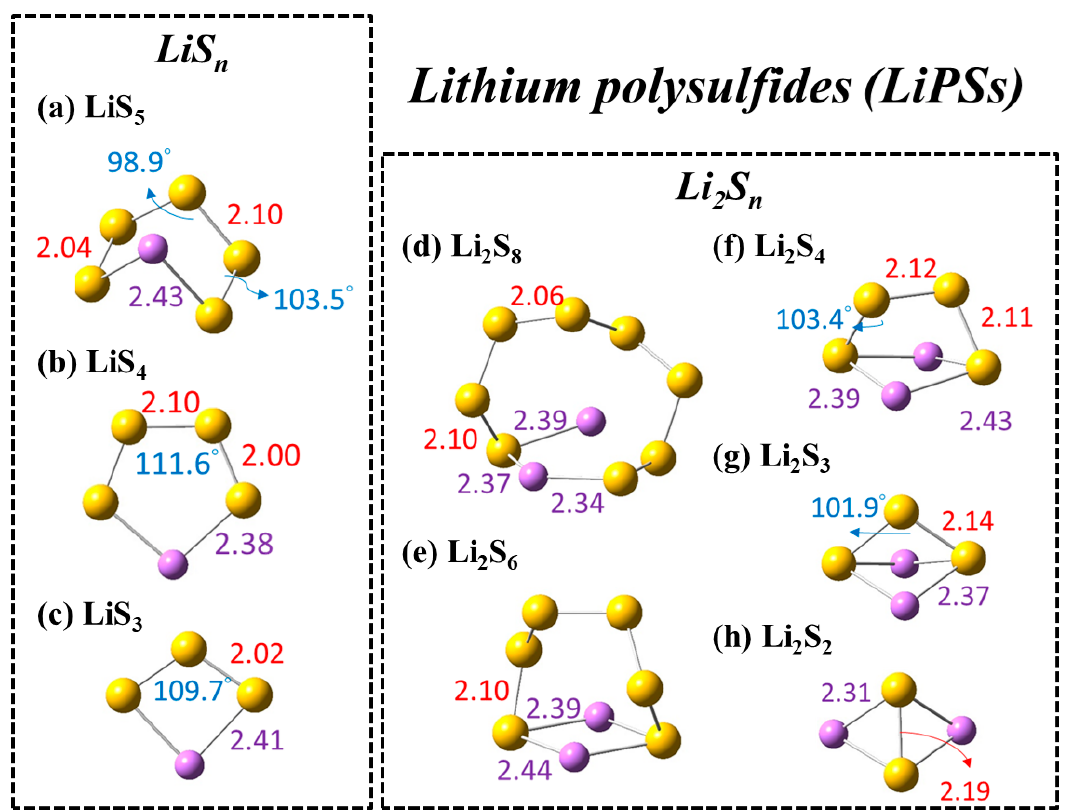
Figure 1. Optimized geometries of different LiPSs in DMSO. The average bond lengths of S-S ( d , in Å) and the bond angles ( θ , in ° ) are labeled in red and purple, respectively.